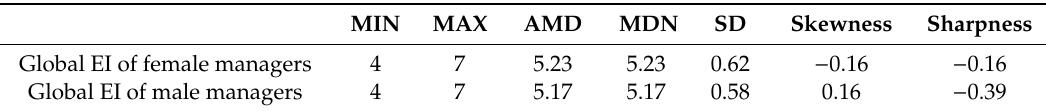
Table 2. Descriptive indicators of the global level of trait emotional intelligence measured by the TEIQue-SF questionnaire for family enterprises managers. MIN MAX AMD MDN SD Skewness Sharpness Global EI of female